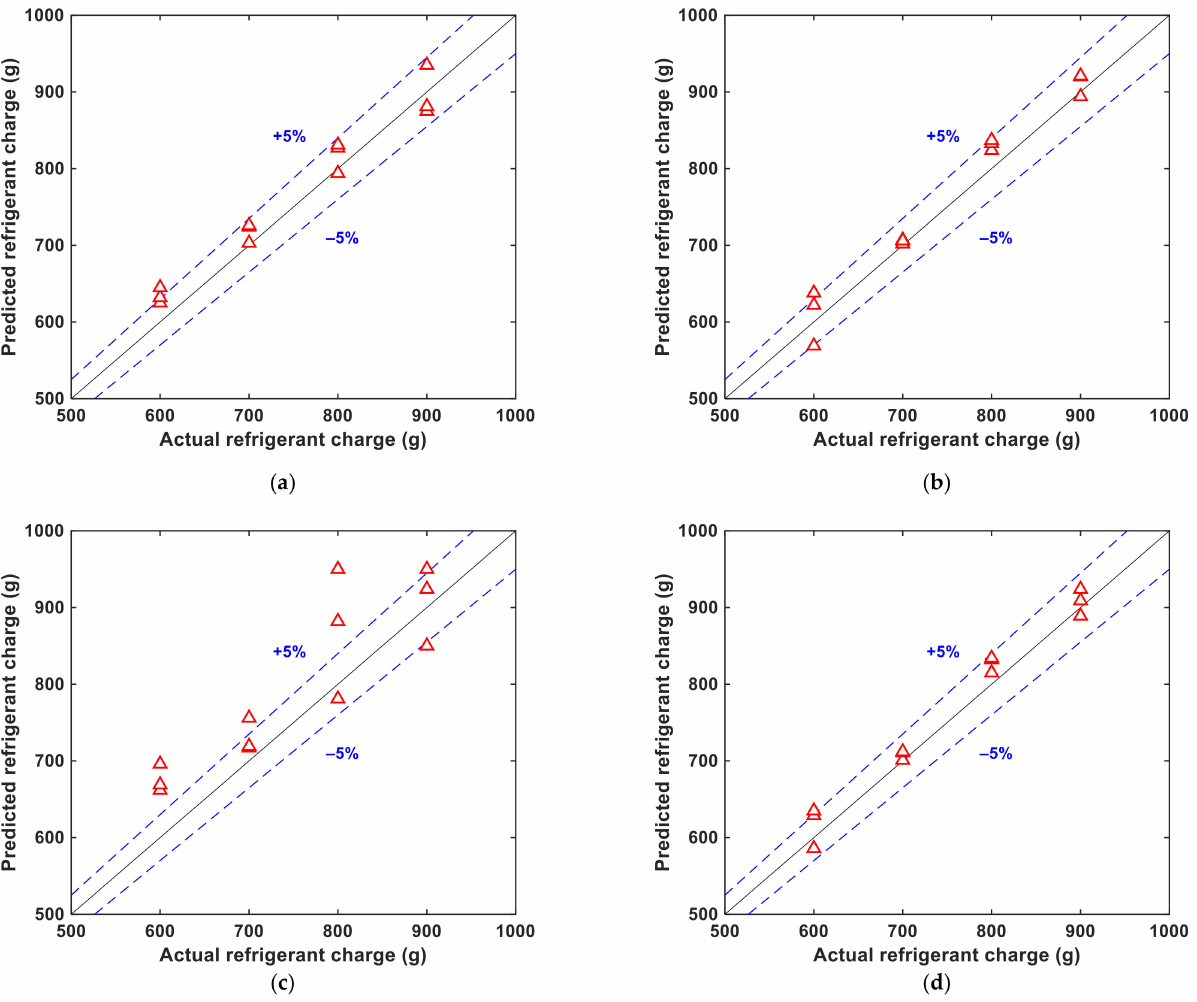
Figure 10. Detection results of refrigerant charge amount for each model using test data: ( a ) condensation tempera- ture; ( b ) degree of subcooling; ( c ) power consumption; ( d ) combination of condensation temperature and degree of subcooling